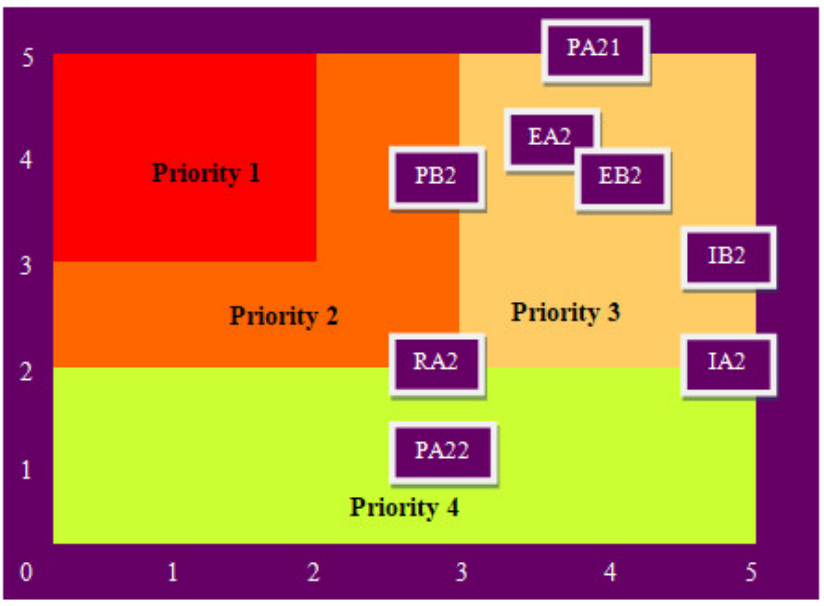
Figure 7. Human rights sustainability assessment